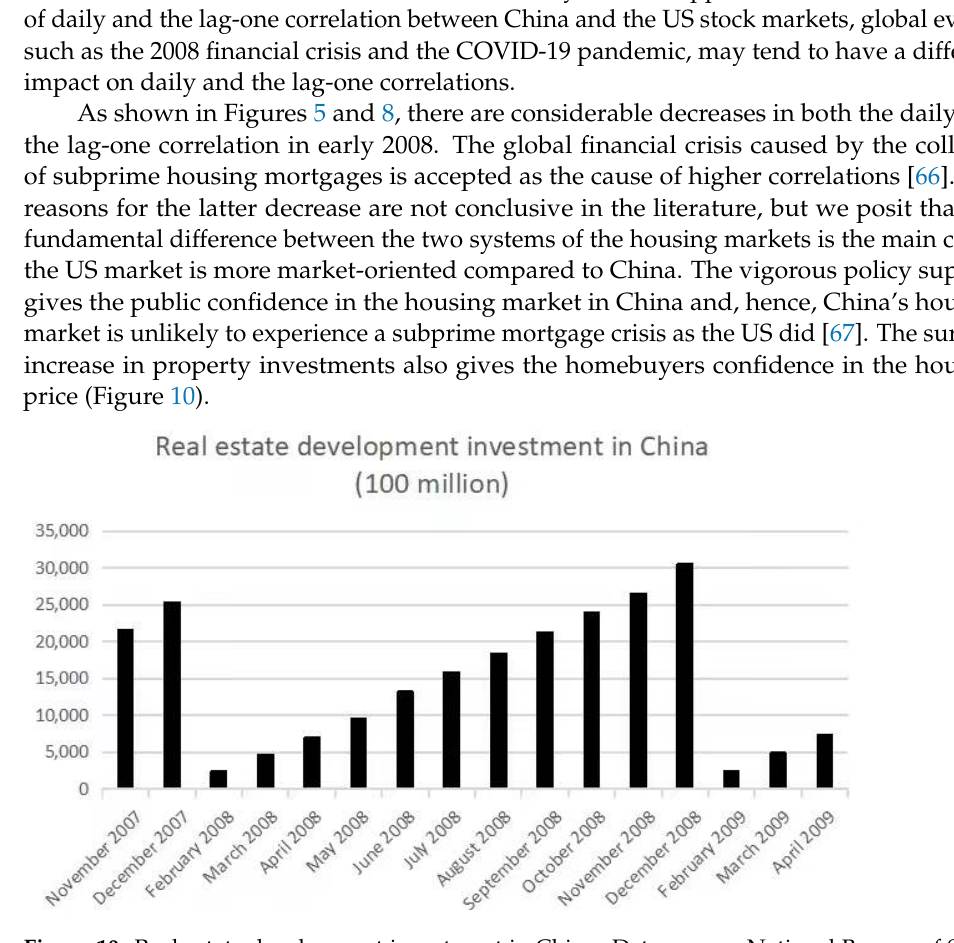
Figure 10. Real estate development investment in China. Data source: National Bureau of Statistics [68]